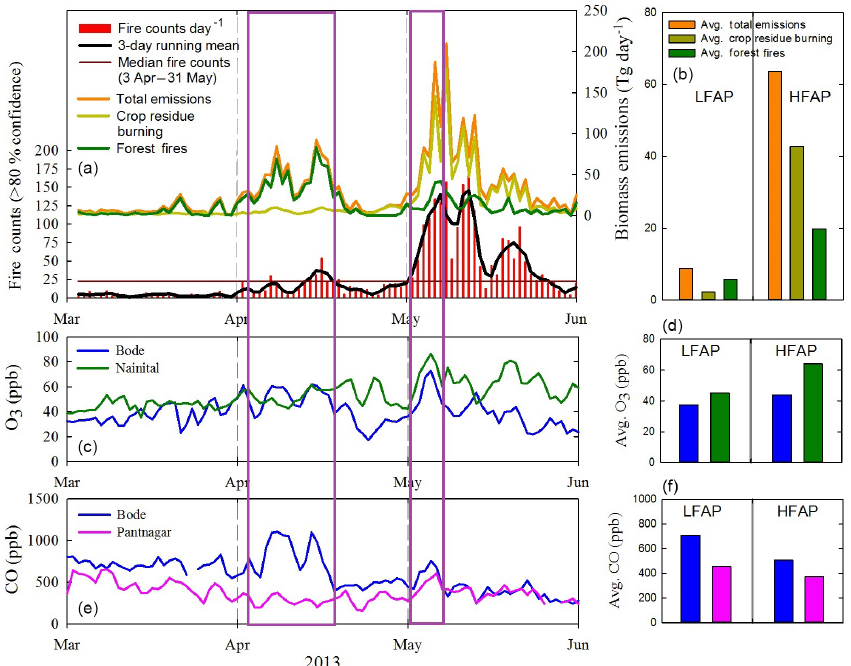
Figure 13. (a) Time series of MODIS daily fire counts (red bar), 3-day running mean (black lines) and median fire counts (brown line) for the fire period (3 April to 31 May 2013). Total biomass burning emissions (orange line), crop residue burning emissions (dark yellow line) and forest fire emissions (dark green) over a 1 ◦ × 1 ◦ grid box around Bode (27–28 ◦ N, 85–86 ◦ E) are also shown. (b) Average biomass burning emissions for two fire activity periods over the Bode region. (c, d) Time series of surface ozone mixing ratios at Bode and Nainital and average ozone mixing ratios during the two fire periods. (e, f) Time series of surface CO mixing ratios at Bode and Nainital and average CO mixing ratios during the two fire periods. The two fire events in April and May are also highlighted (in violet